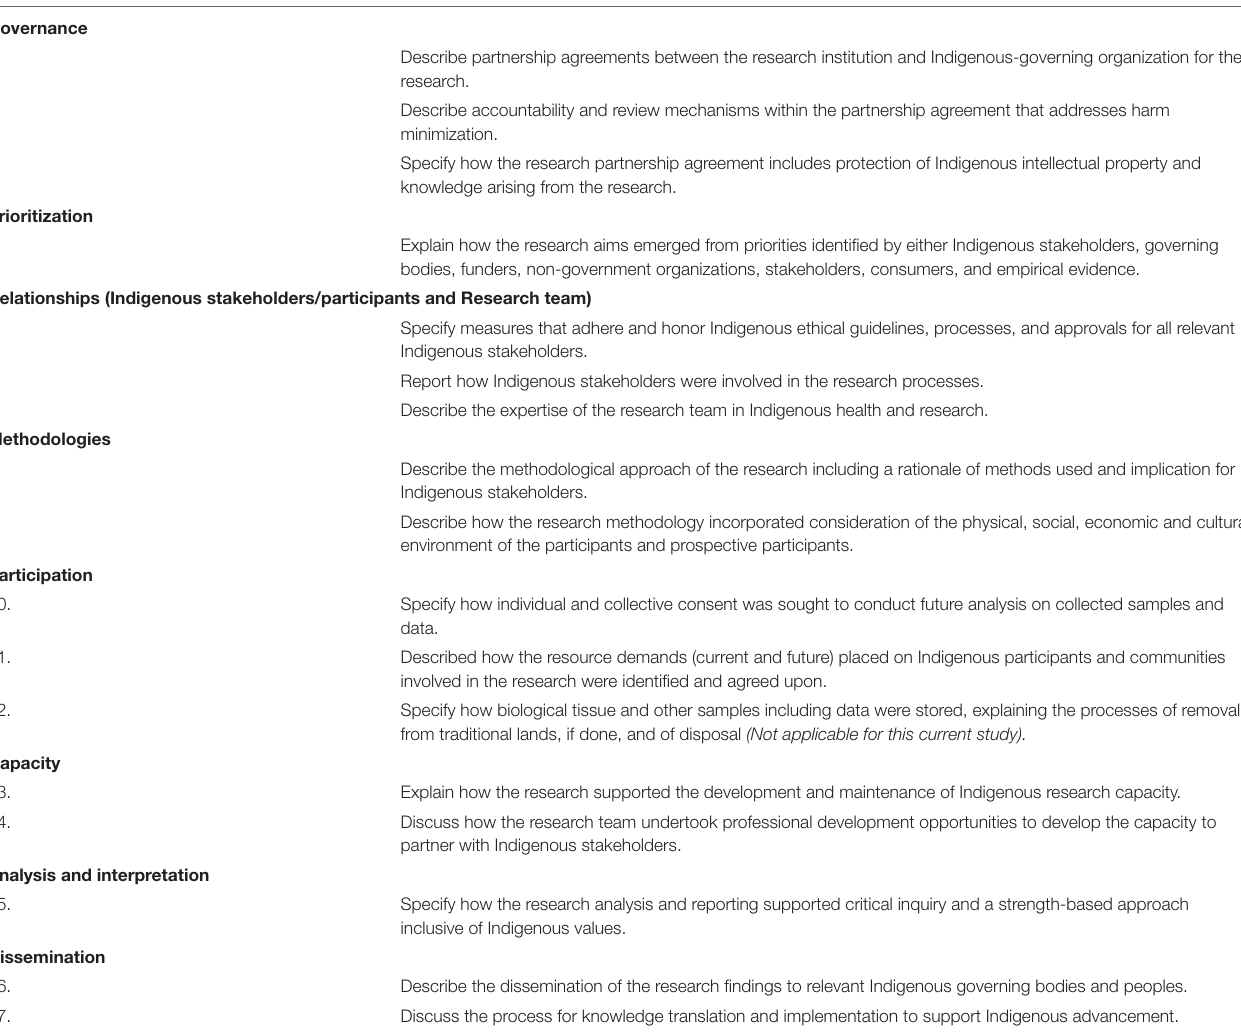
TABLE 4 | Consider checklist: items to include when reporting health research involving Indigenous